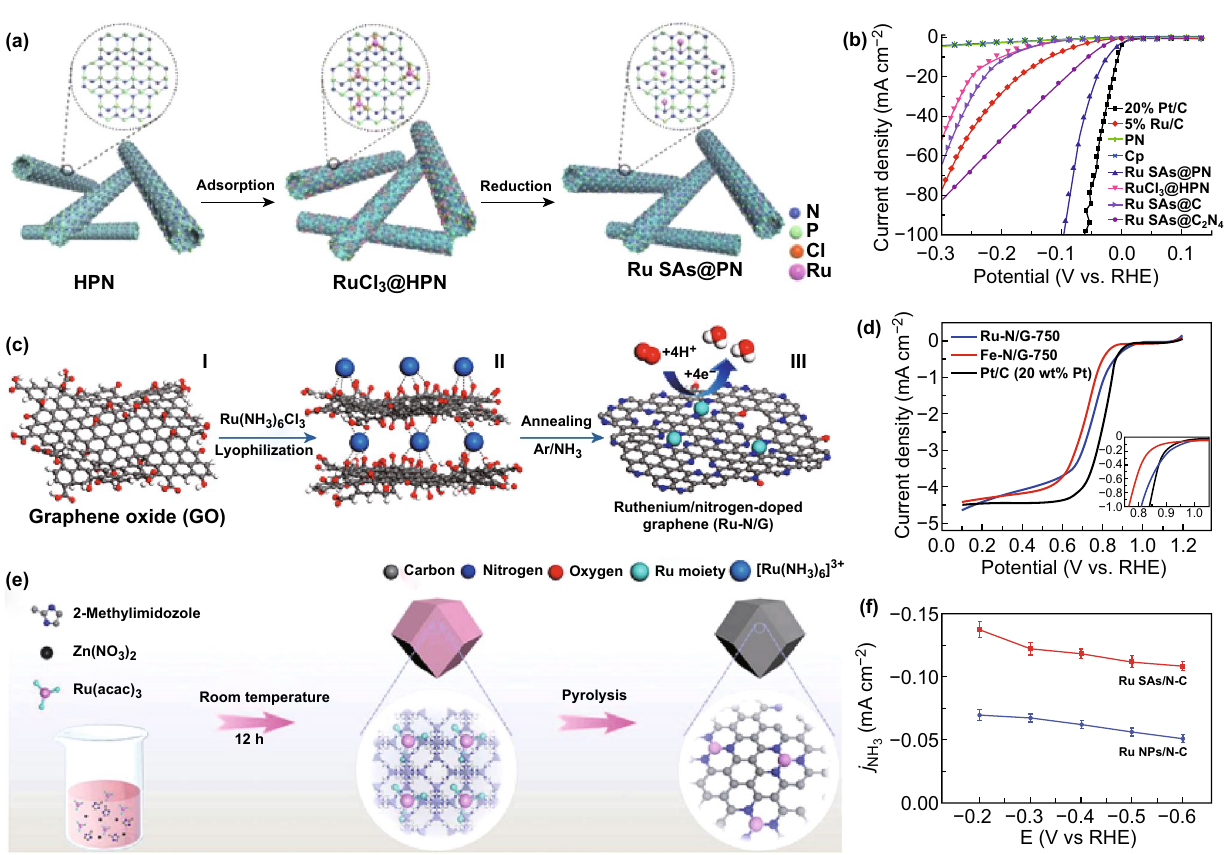
Fig. 10 a Preparation process of Ru SAs@PN. b Polarization curves of the samples. c The synthetic process for the Ru–N/G-750. d Polarization curves of Ru–N/G-750, Fe–N/G-750 and Pt/C in O 2 -saturated 0.1 M HClO 4 solutions. e Scheme of the synthetic procedure for Ru SAs/N–C. f Current densities for NH 3 production. a , b , e , f Reproduced from Refs. [126, 173] with permission. Copyright 2018 Wiley-VCH. c , d Repro- duced from Ref. [106] with permission. Copyright 2017 American Chemical